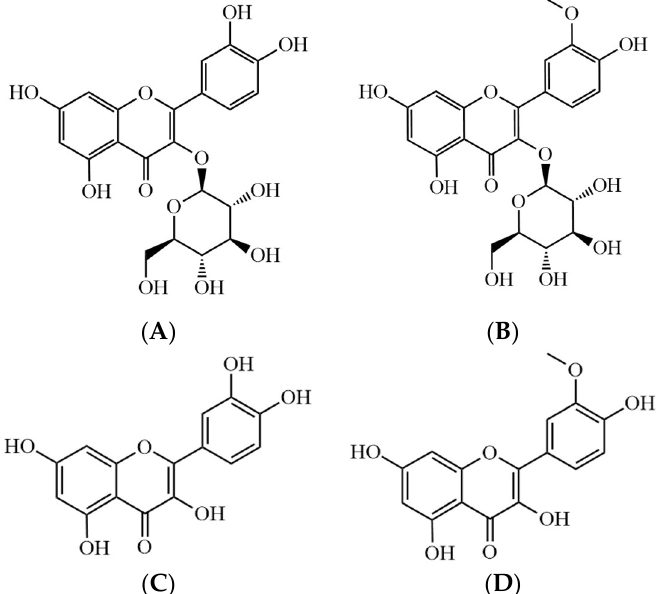
Figure 1. Chemical structures of ( A ) Q3G, ( B ) I3G, ( C ) quercetin, and ( D ) isorhamnetin. Quercetin 3- O -glucoside (Q3G), isorhamnetin 3- O -glucoside (I3G).